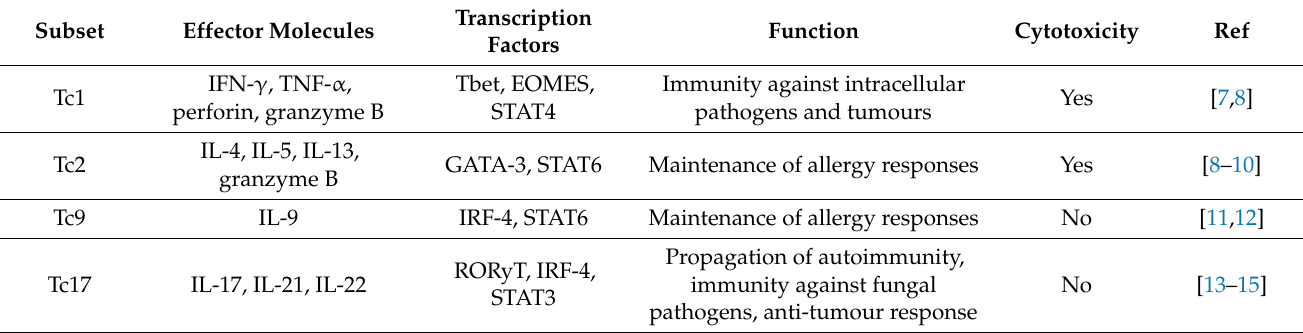
Table 1. Overview of CD8 + T cell effector populations and their known functions.